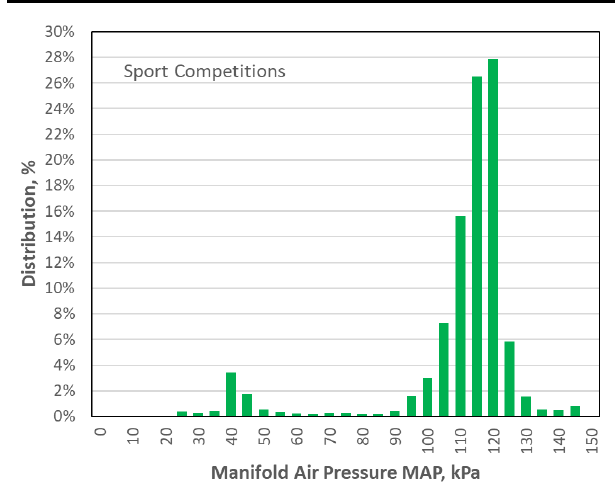
Fig. 9. Distribution of manifold air pressure during the sport competition